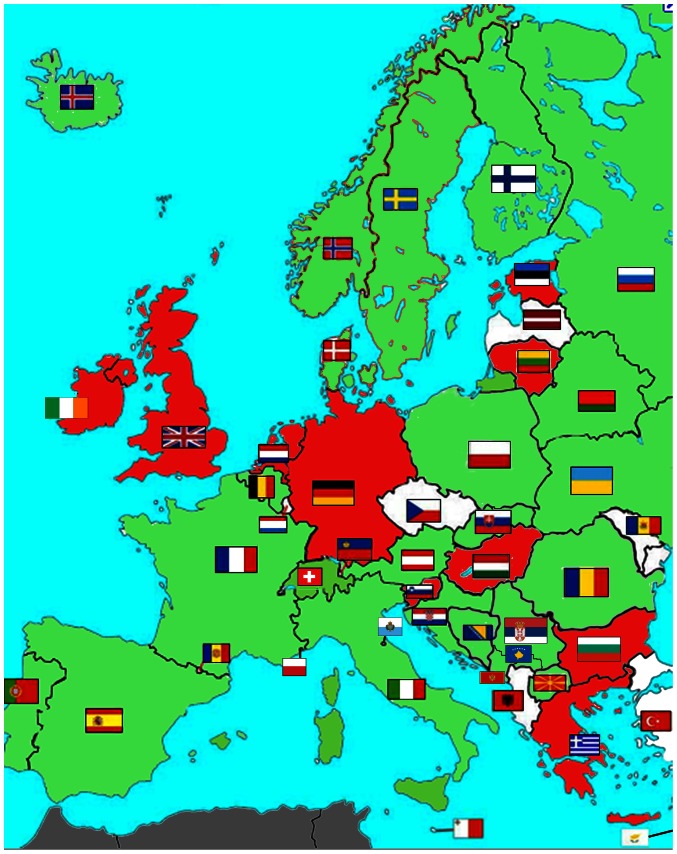
Map of Europe.European countries with mushroom legislation or guidelines (green), without them (red), or with no information available (white).